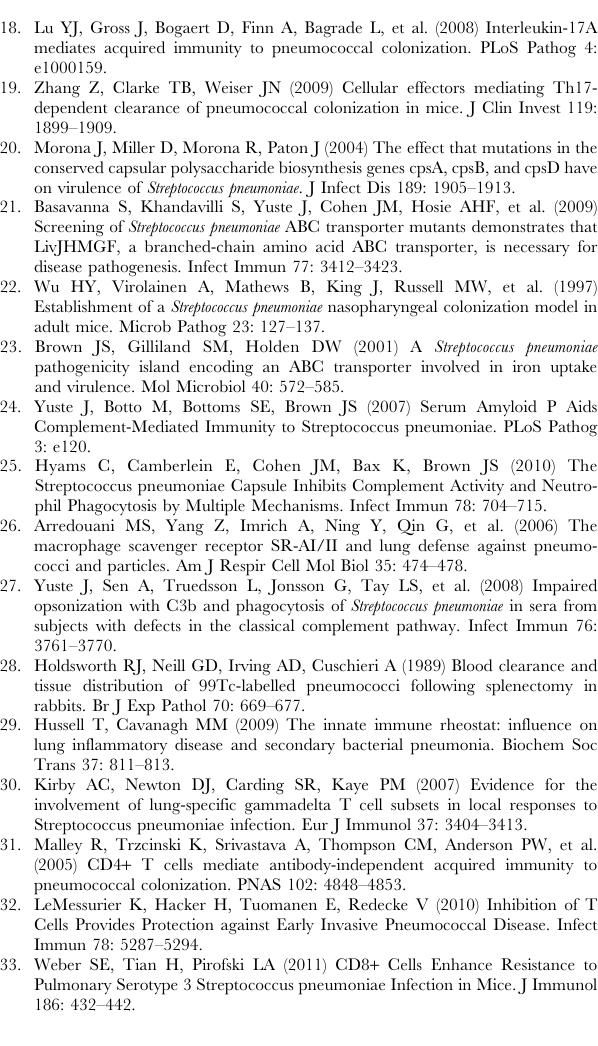
Figure 8. Colonisation induces serum opsonophagocytic antibody. (A–B) Flow cytometry assays of neutrophil phagocytosis of FAM-SE labelled D39 after incubation in serum from either (A) colonised or control CBA/Ca mice or PBS, or (B) colonised or control m MT mice or PBS. A representative histogram is shown on the left (clear PBS, black 20% control sera, grey 20% colonised sera), and mean MFI 6 SEM (n=4 replicates) for each condition in the graph on the right. (C) MFI of alveolar macrophages present in BALF of previously colonised or control CBA/Ca mice 4 h following challenge with 10 7 cfu FAM-SE-labelled D39 S. pneumoniae . Dots represent individual mice, bars represent medians. (D) Numbers of cfu of S. pneumoniae recovered from blood of colonised or control mice inoculated intravenously with 5 6 10 6 cfu S. pneumoniae D39 (n=6 per group) at 2 and 5 h. Dots represent data from individual mice, bars represent group medians.